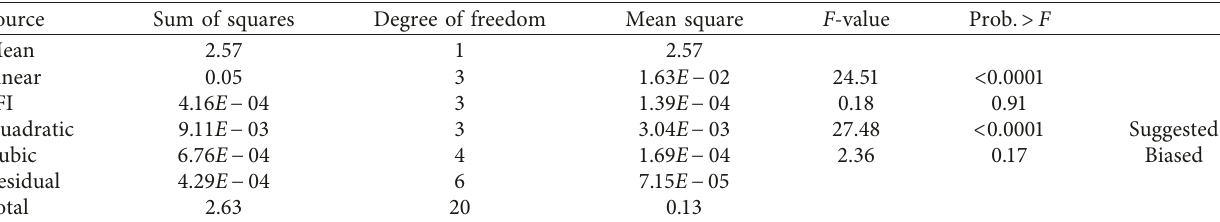
Figure 2: Effect of individual independent variables: (a) extraction time, (b) extraction solid/liquid ratio, and (c) extraction temperature on total flavonoids (TF) extraction rate. Table 3: Sequential model sum of squares.